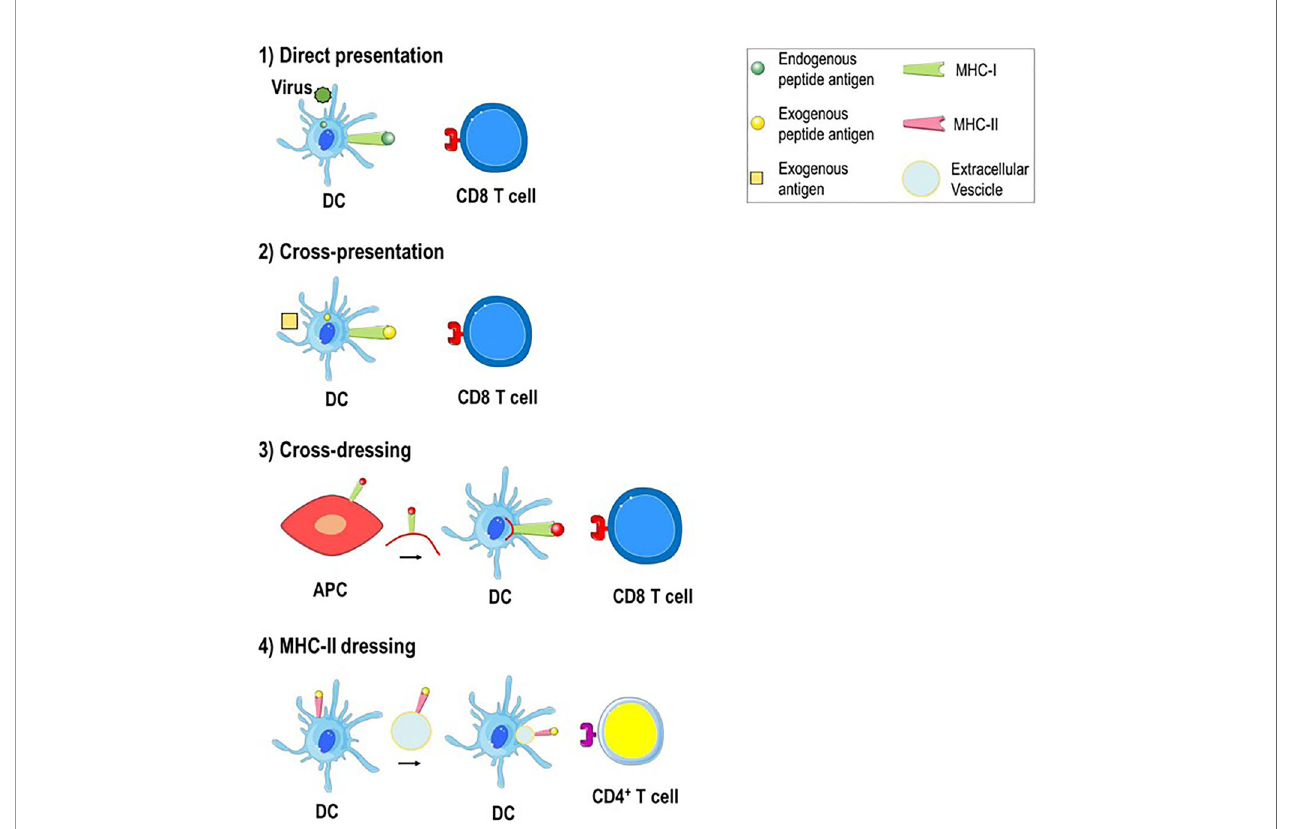
FIGURE 2 | Mechanisms of antigen presentation in the liver. 1) Direct presentation. Within virus-infected DC, the endogenous antigen is broken down into peptides that bind to endogenous MHC class I molecules and are presented to antigen-speci fi c CD8 + T cells. 2) Cross-presentation. An exogenous antigen, such as a virus that do not infect DC, is engulfed by DC, processed and derived peptide antigens are presented to CD8 + T cells through MHC class I molecules. 3) Cross-dressing. The peptide-MHC class I complex is transferred from APC to DC by trogocytosis or extracellular vesicles. 4) MHC-II dressing. The peptide-MHC class II complex is transferred (through trogocytosis/extracellular vesicles) from DC to neighboring DC which can use it to activate CD4 + T